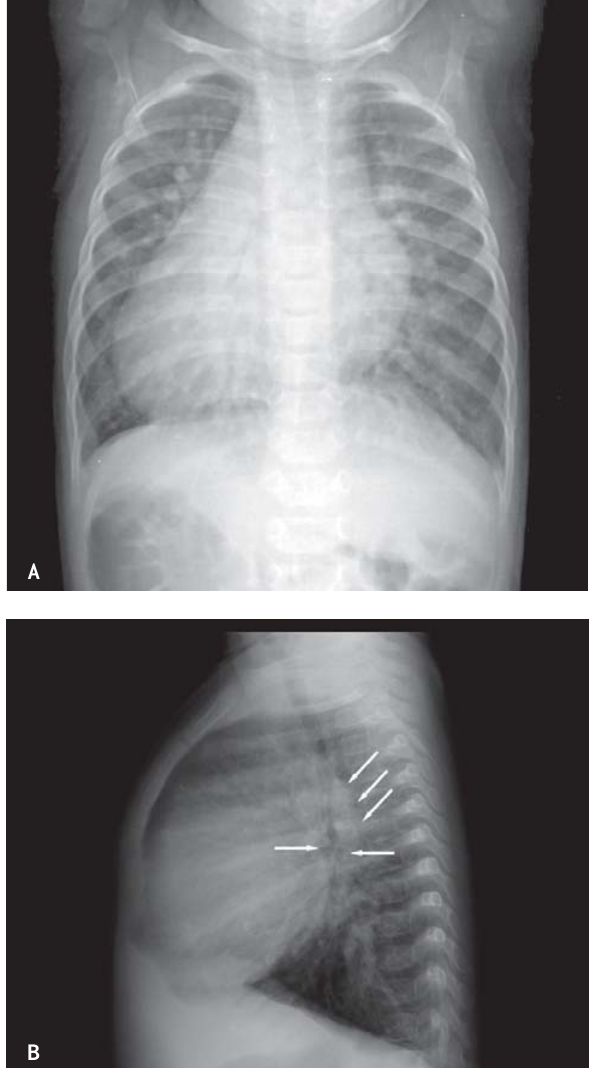
Fig. 2 – Radiografias de tórax: (A) Frente em PA com dextrocardia e aumento de área cardíaca. (B) Perfil esquerdo com duas artérias